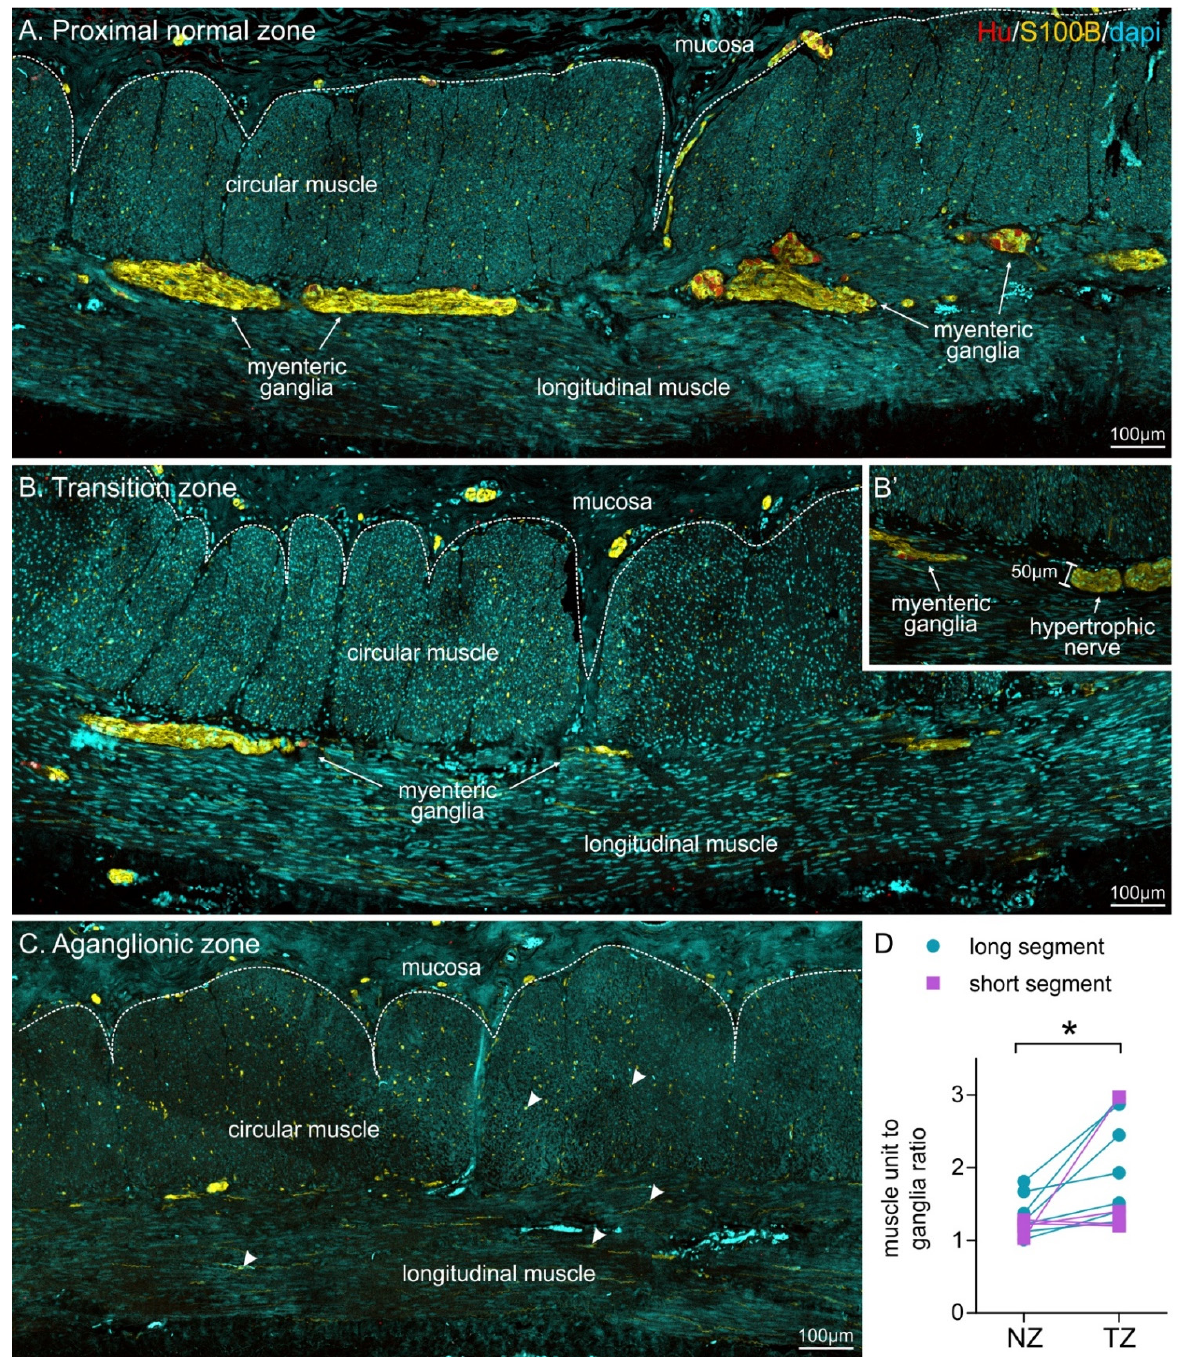
Figure 2. Overview of the distribution of myenteric ganglia in relation to circular muscle units in the proximal normal zone ( A , NZ), the transition zone ( B , TZ), and the aganglionic zone ( C ) in longitudinal sections of HSCR patient tissue following immunohistochemistry against HuC/D (Hu), S100B and DAPI. Ganglia are more sparsely located in the transition zone, and no ganglia are visible in the aganglionic zone, although individual glial cells are present (some highlighted by arrowheads). ( B’ ) shows a hypertrophic nerve bundle, which could be identified using S100B immunohistochemistry, but lacked neuronal cell bodies. Hypertrophic nerve bundles had a minimum width of 40 µ m. ( D ) quantification of muscle unit to ganglion ratio in both long- and short-segment patients (* p = 0.012, n = 11, paired t